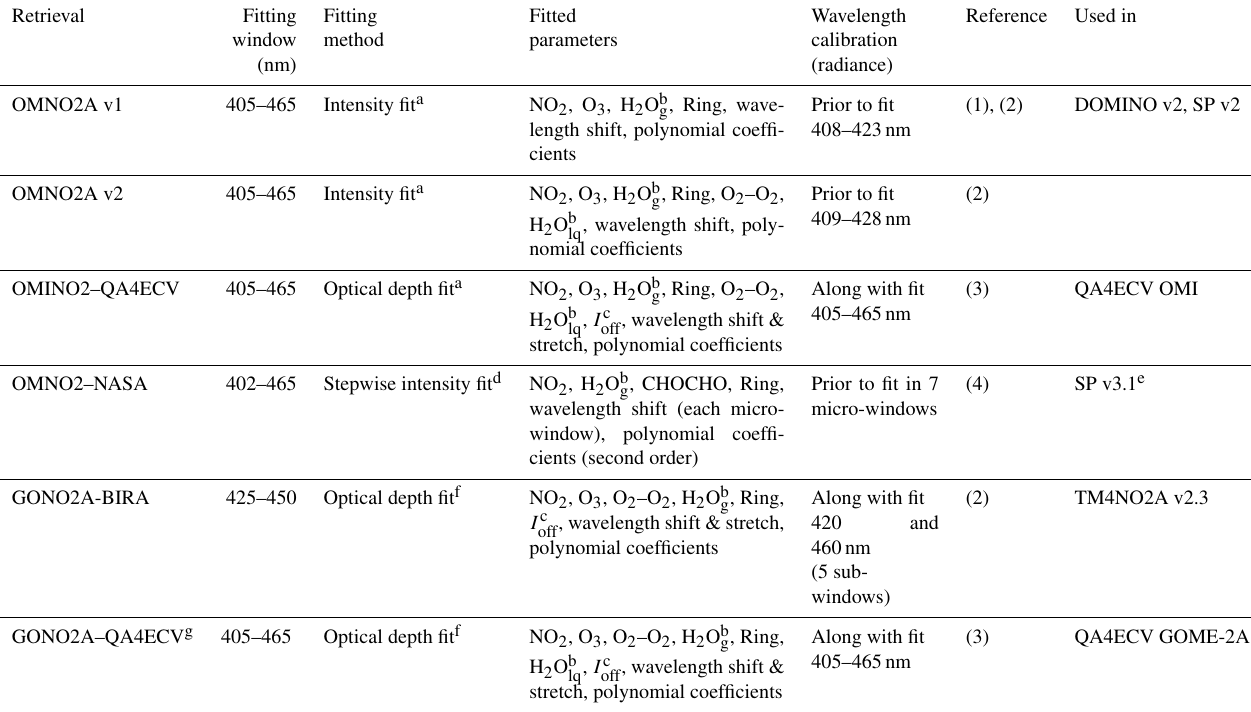
Table 2. Satellite NO 2 slant column density retrievals evaluated in this work.